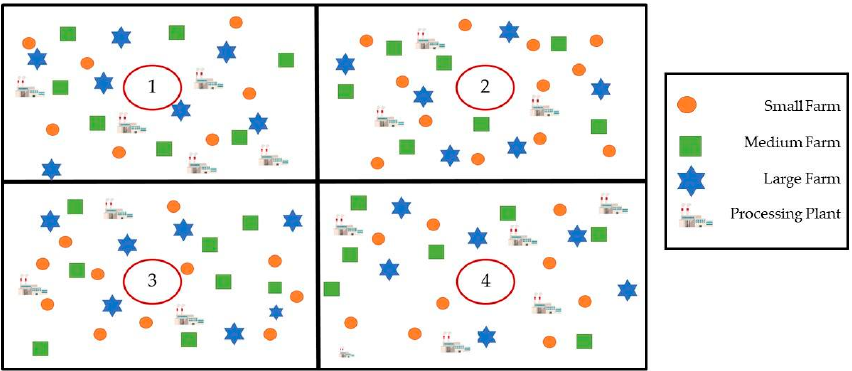
Figure 2. Characteristics of the freeze zone.